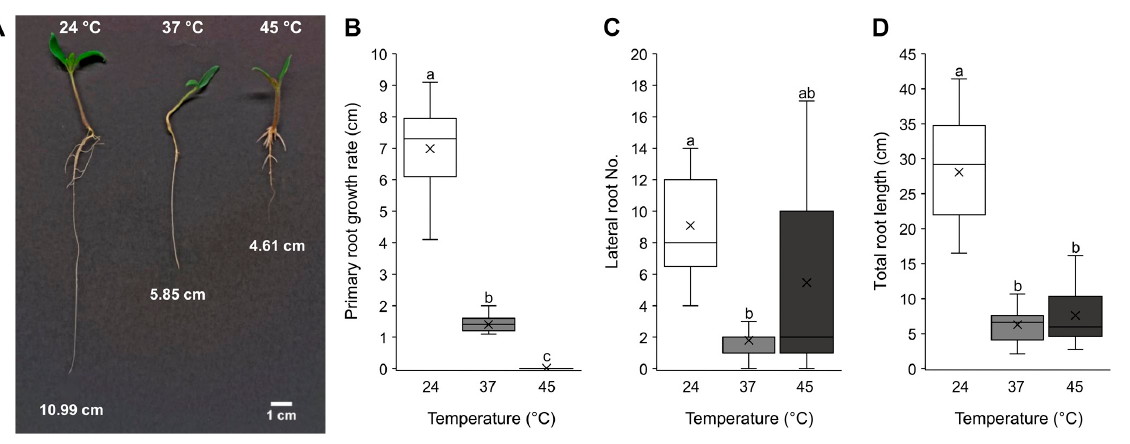
Figure 3. Effects of heat stress on seedling root development. Seven-day-old seedlings were exposed to 37 ◦ C or to heat wave at 45 ◦ C for 3 h and further cultured at 24 ◦ C (Figure S1B). Control plants were kept at 24 ◦ C. The seedlings were analyzed and photographed ( A ) 5 days after the start of heat treatments. Primary root growth rate ( B ), lateral root number ( C ) and total root length ( D ) were measured. Data are represented as boxes that indicate the lower and upper quartile while means and medians of 15 seedlings are denoted with a horizontal line and a cross in the box, respectively. Whiskers represent the highest and lowest scores in the data set. Different letters indicate a significant difference at p < 0.05 (Tukey’s test). The scale bar is 1